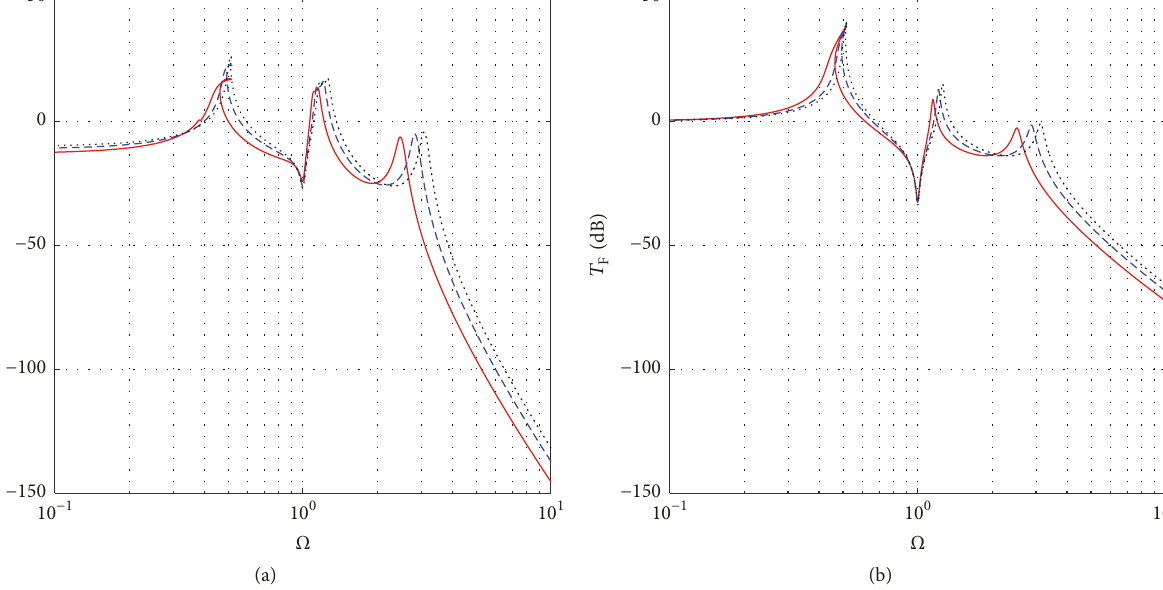
Figure 6: Power transmissibility (a) and force transmissibility (b) of the two-stage HSLDS system with different ratio of are 𝜇 1 = 0.2 , 𝜇 2 = 1 , 𝜆 1 = √5 , 𝜆 2 = 1 , blue dashed line,